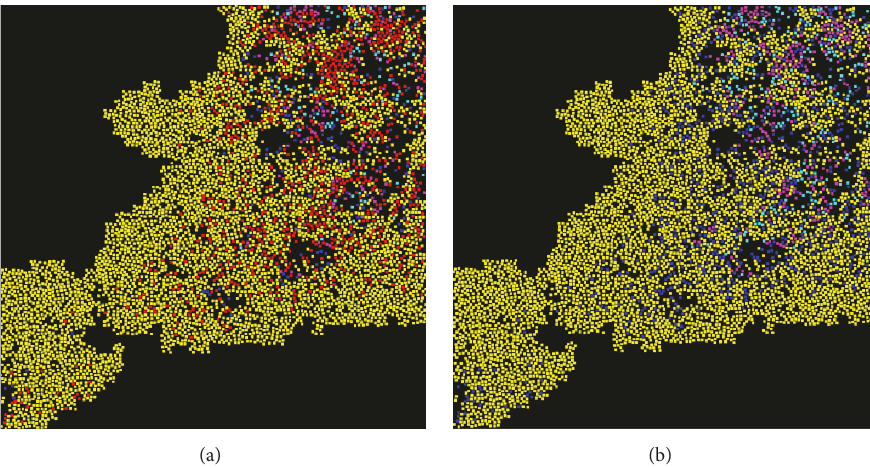
Figure 9: In (a), points in red are the plant positions that have been assigned to multiple plant species. On (b), these conflicts have been resolved by taking the plant species with the highest fractal for a conflicted point.